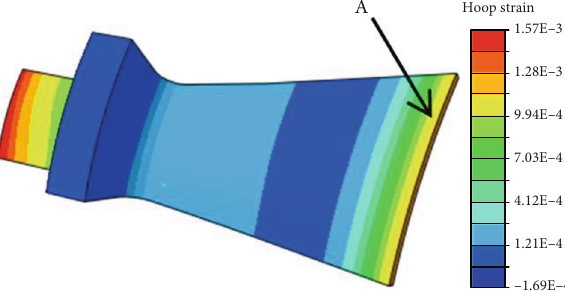
Figure 13: Hoop strain distribution of metal case with simulation.